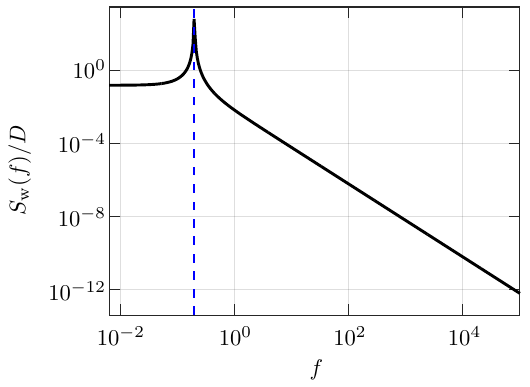
Fig. 4. The variation of the real part of the eigenvalue corre- Figure 4: The variation of the real part of the eigenvalue correspond- sponding to the wake modes, where Re( λ w+ ) is derived using ing to the wake modes, where Re( λ w+ ) is derived using the compu- Fig. 3. The profile of the wake mode near t = 0 . The sharp spike the computational method that is described in [62], and λ K is tational method that is described in [62], and λ K is calculated using in all curves around t = 0 corresponds to the location of the calculated using Eq. (81). Eq. (81). modelocked pulse.